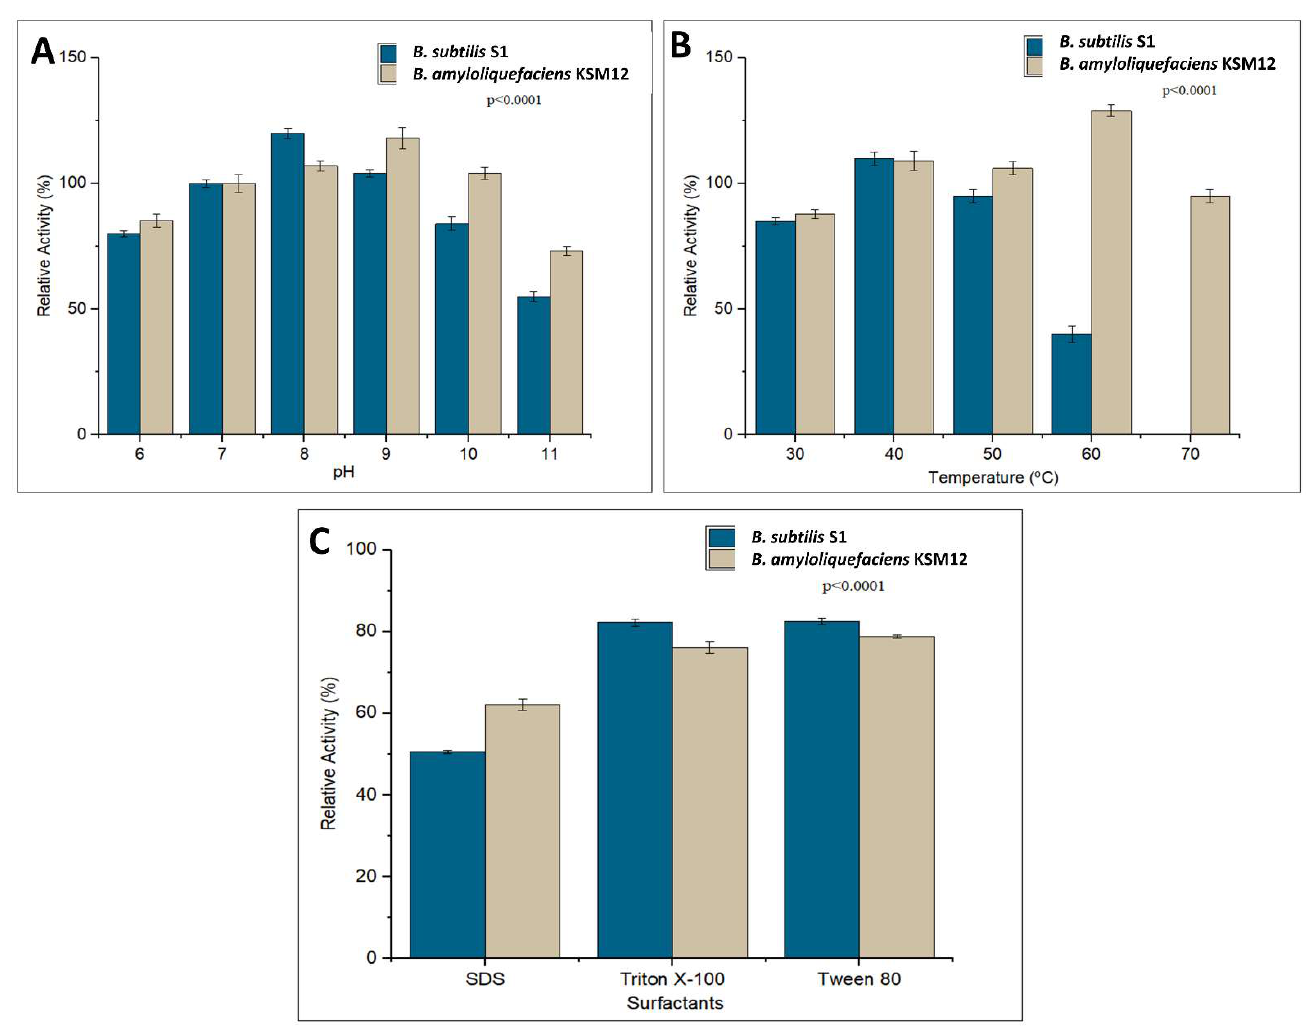
Figure 6. Physicochemical characterization of partially purified proteases of B. subtilis S1 and B. amyloliquefaciens KSM12. ( A ) Effect of pH (F = 112.97, p < 0.0001), ( B ) effect of temperature (F = 177.37, p < 0.0001), and ( C ) effect of surfactants (F = 378.01, p < 0.0001).